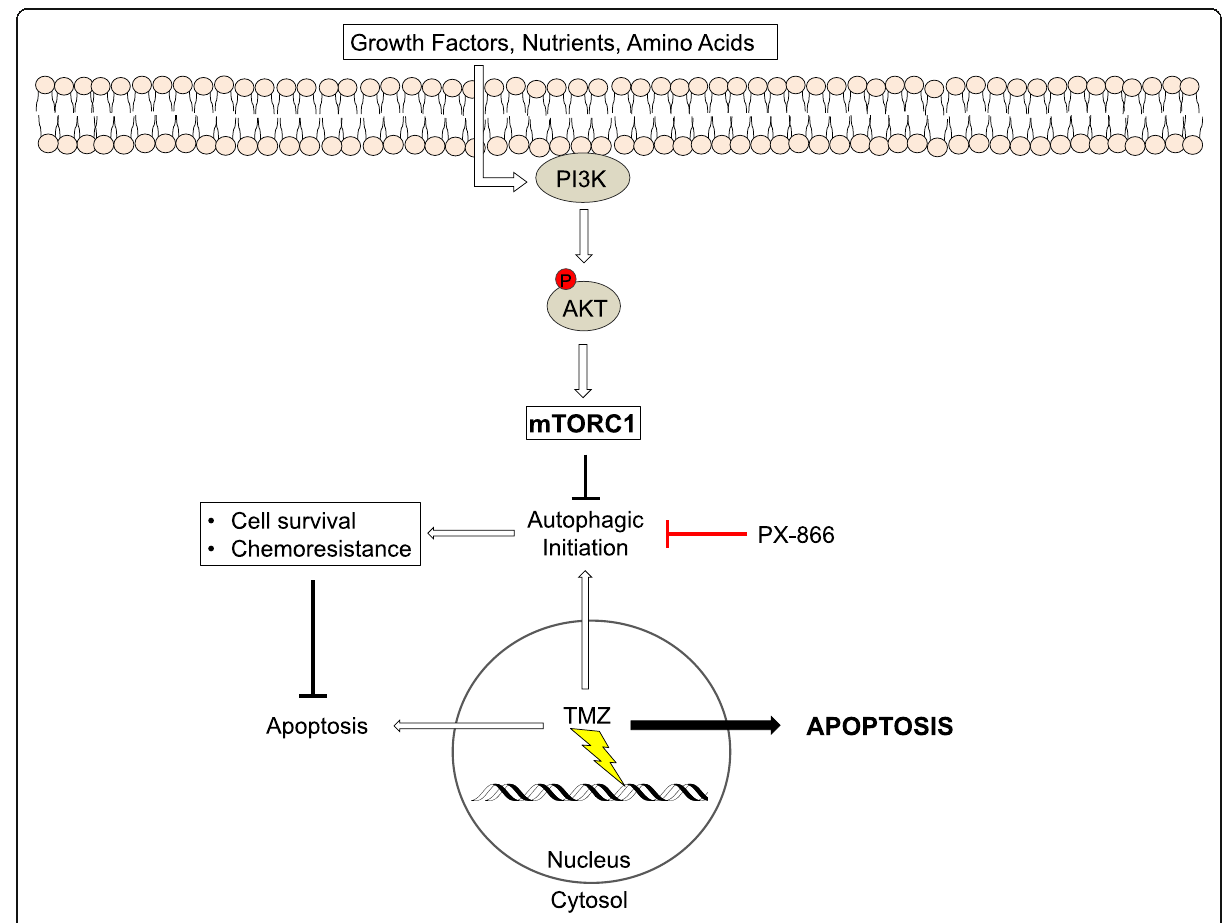
Fig. 6 Schematic of the proposed mechanism of how PX-866 cooperates with TMZ to enhance apoptosis through inhibition of TMZ-induced